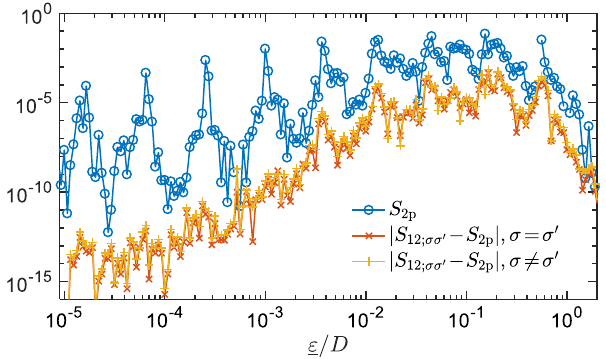
FIG. 14. Exemplary discrete 2 p PSFs of the AIM, with the same parameters as used in Figs. 2(a), 2(b), 4, and 6. Blue circles † ε Þ ¼ S ½ d denote the 2 p PSF S 2 σ (cid:2)ð ε Þ obtained directly by the σ ; d p ð 2 p shell-diagonal expansion. The weights S ε Þ are clustered. 2 p ð Clusters are sharply concentrated (note the logarithmic scale of the ordinate), and the logarithms of their center positions are separated by ∼ log Λ . Red × ’ s and yellow þ ’ s show the difference ε Þ . of the 2 p PSFs, derived from 4 p PSFs via sum rules, from S 2 p ð The PSFs are obtained by using discretization parameters Λ ¼ 4 and z ¼ 1